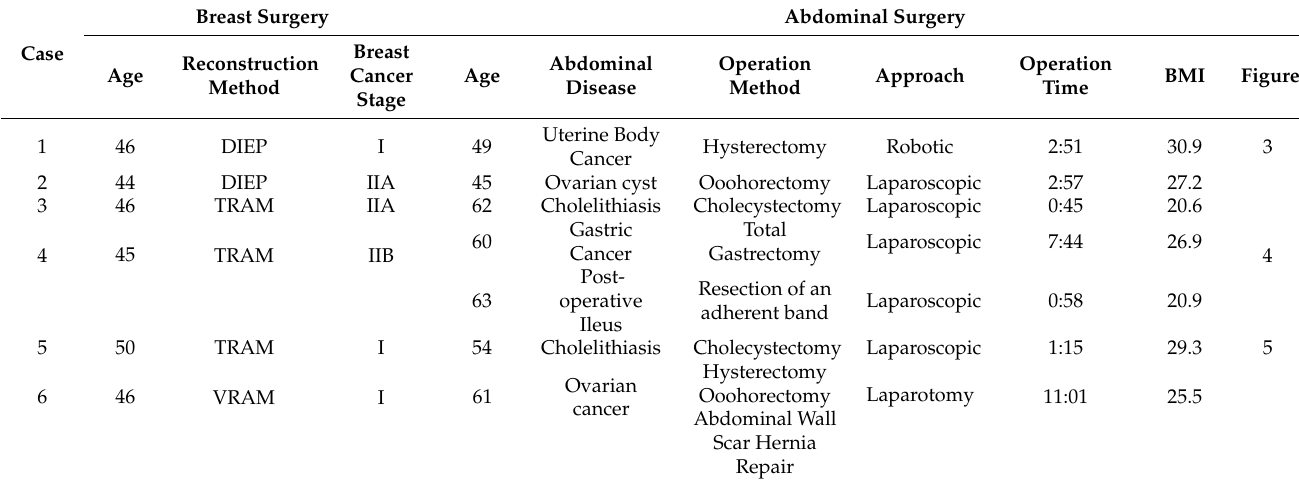
Table 2. Seven cases of abdominal surgery after VRAM/TRAM or DIEP reconstruction.